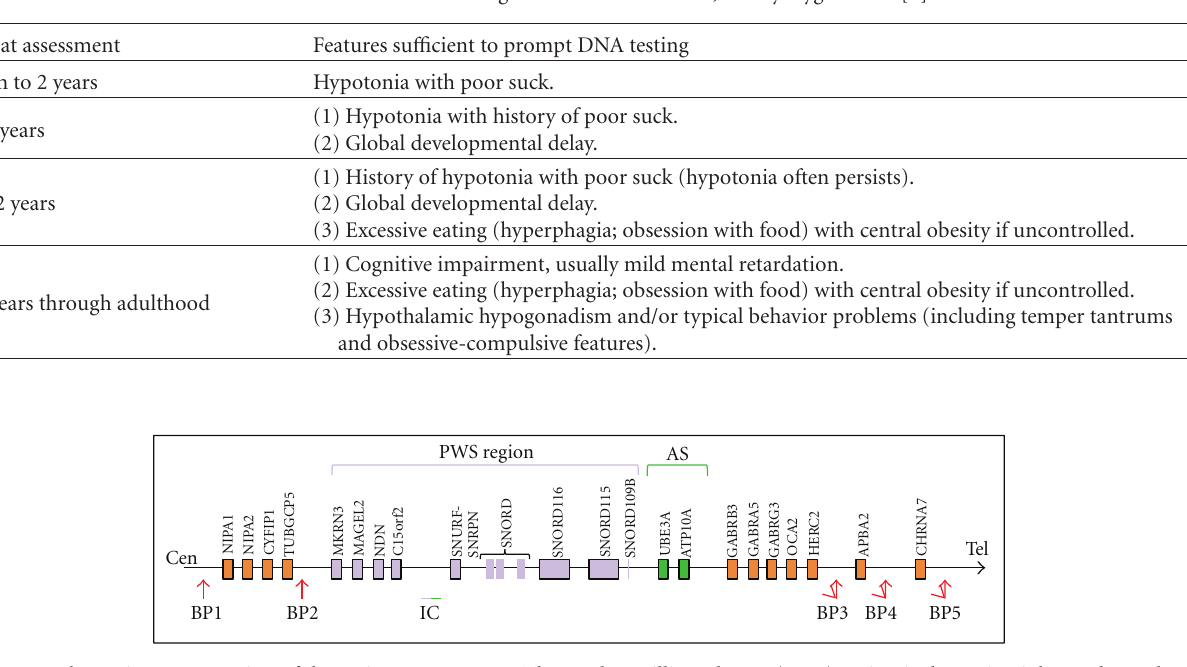
Figure 1: Schematic representation of the region 15q11.2-q13. The Prader-Willi syndrome (PWS) region is shown in violet, and Angelman syndrome (AS) region is shown in green. The red arrows indicate the three deletion breakpoints common to PWS and AS (BP1, BP2, and BP3). On rare occasions, there will be a distal breakpoint at BP4 or BP5. Type-1 deletions (T1D) extend from BP1 to BP3, and type-2 deletions (T2D) extend from BP2 to